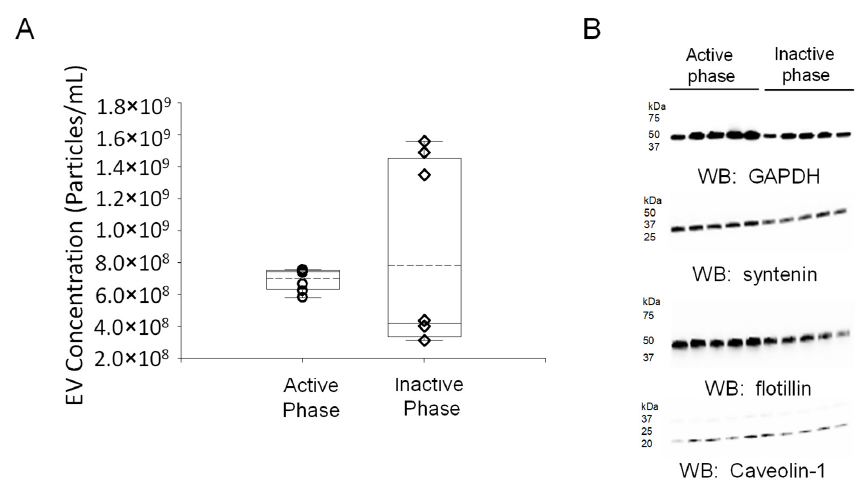
Figure 3. Concentration and Western blot characterization of EVs isolated from urine samples collected during the inactive and active phase of spontaneously hypertensive male C57B6 mice. ( A ) Summary plot of uEV concentration from urine produced during the active phase and collected at 8 AM and from urine produced during the inactive phase and collected at 8 PM. ( B ) Western blot (WB) analysis of multiple EV markers including GAPDH, syntenin, flotillin, and caveolin-1. A Wilcoxon rank sum test was performed to compare the two groups. n = 7 EV preps in each group. The open circles represent individual data points from the AP group and the open triangles represent individual data points from the IP group.